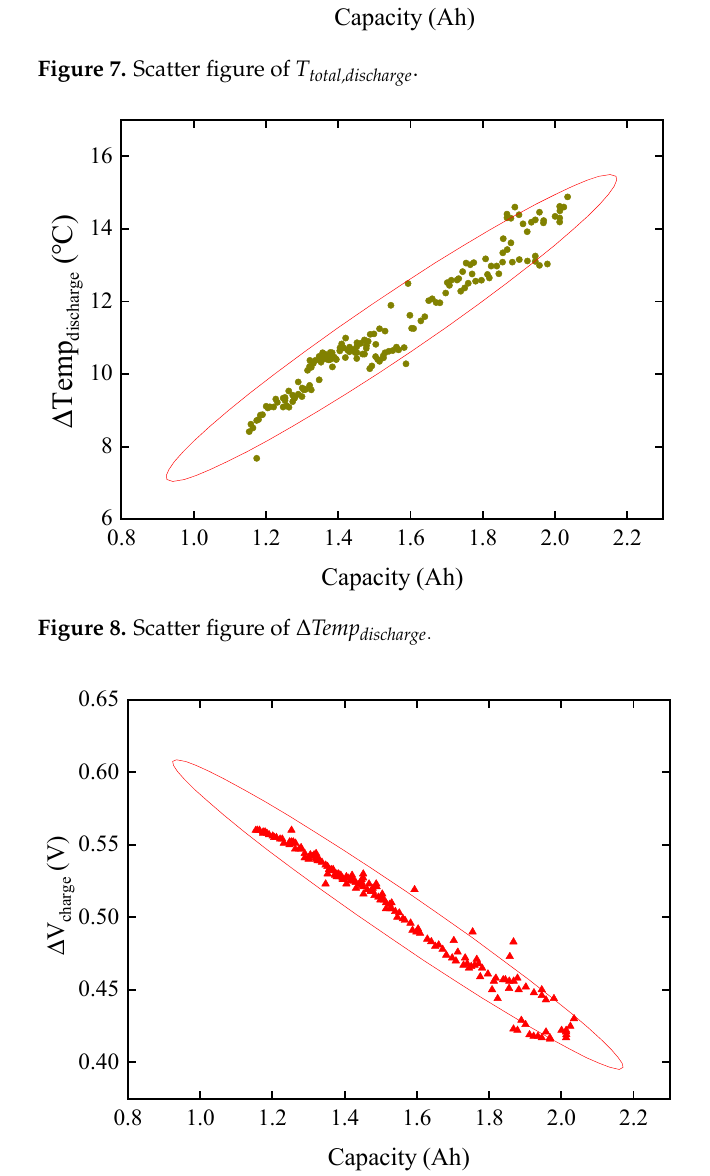
Figure 10. Scatter figure of Δ V charge . Table 3. Judgment criteria between the degree of correlation and the correlation coefficient . The absolute value of the correlation coefficient